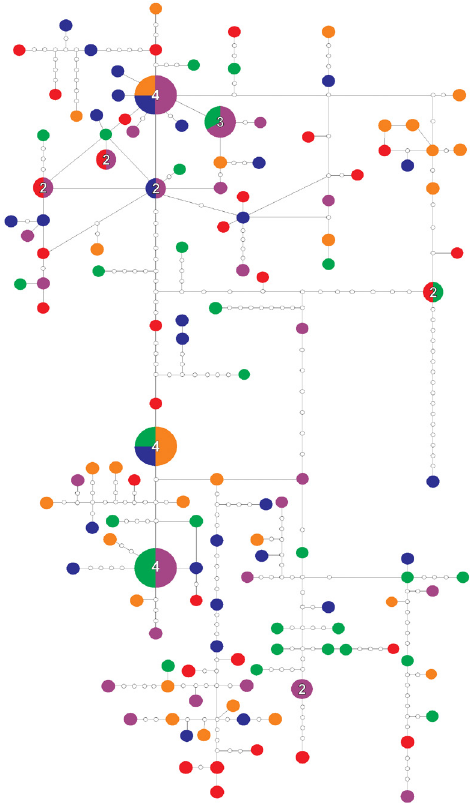
FIGURE 2 | Network of Brachyplatystoma vaillantii haplotypes. The number shown within a circle identifies the number of specimens sharing those haplotypes; circles without numbers represent unique haplotypes. White circles represent hypothetical intermediate haplotypes. Each locality is represented by the same colors in Fig. 1: red – Tabatinga, orange – Tefé, green – Manaus, purple – Santarém and blue –